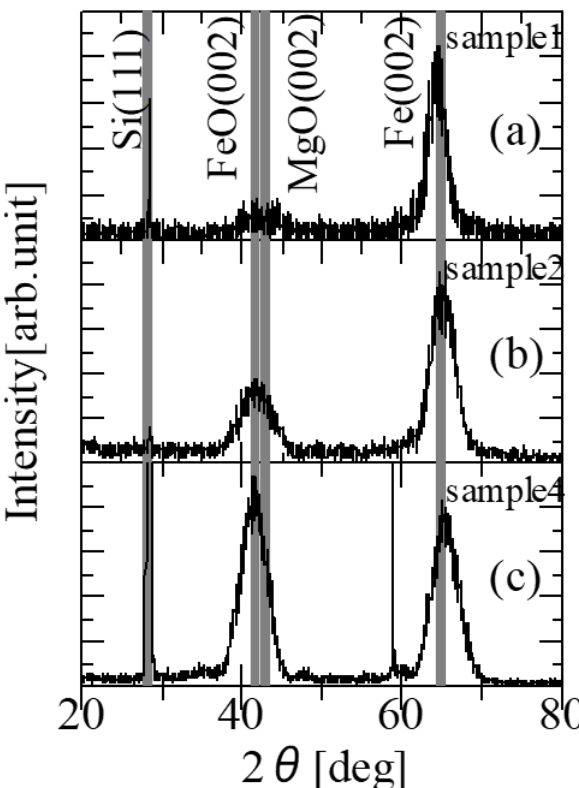
Figure 1. X-ray diffraction pattern for ( a ) Fe(10 nm)/MgO(1 nm), ( b ) Fe(4 nm)/MgO(1 nm) and ( c ) intentionally oxidized Fe(4 nm)/MgO(1 nm) multilayered films. The gray lines indicate PDF data (Si(27-1402), Fe(06-0696), MgO(45-096) and FeO(89-0686)).